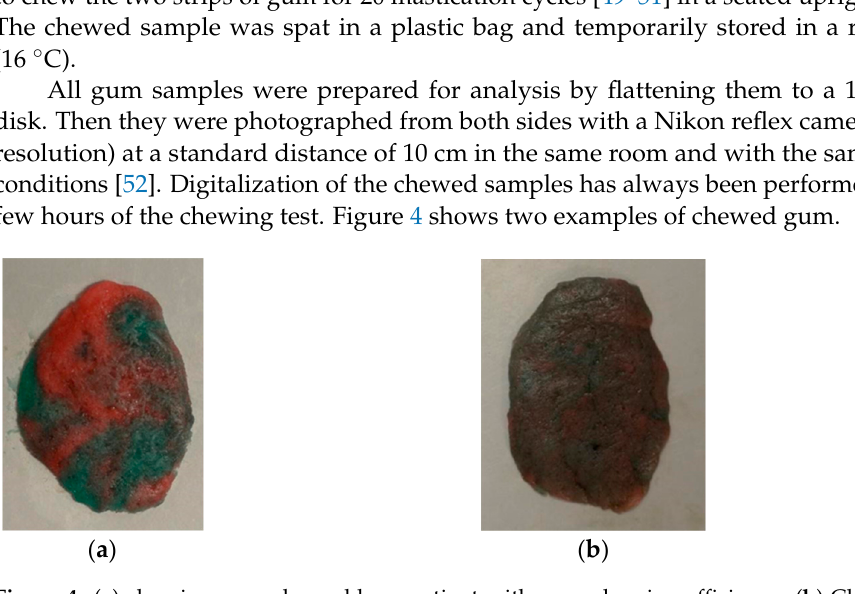
Figure 3. ( a ) External view of the gnathodynamometer with piezoresistive sensors. ( b ) Gnathodynamometer’s electronics.